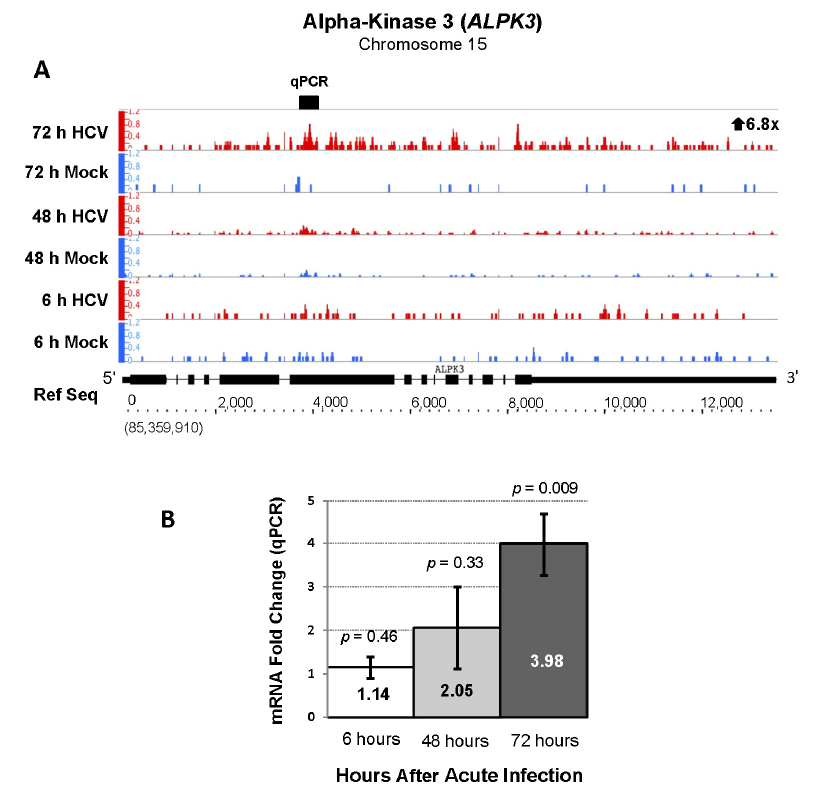
Figure 7. Increased expression of Alpha-kinase 3 ( ALPK3 , chr 15, + strand) during acute HCV infection. RNA sequencing analysis of acutely infected Huh 7.5 cells showed a 6.8 fold increase ALPK3 mRNA with a highly significant FDR value of 202.4. ( A ) and qPCR analysis verified a significant increase ( B